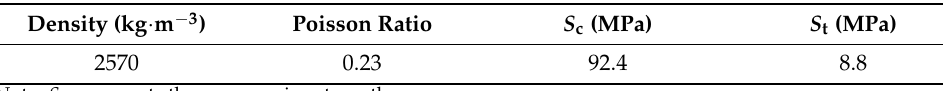
Table 2. Physical and mechanical parameters of rock.